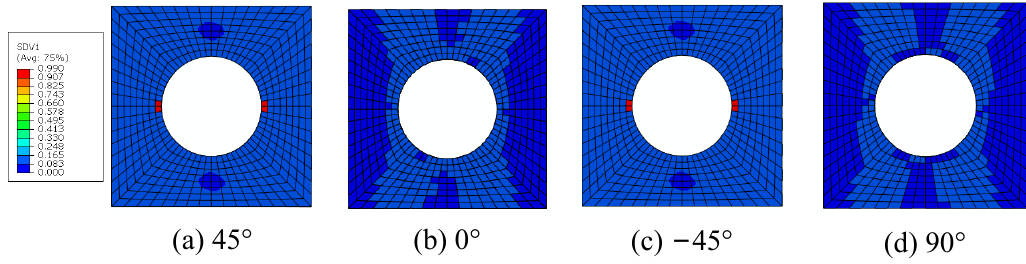
Figure 21. The initiations regions for matrix damage.